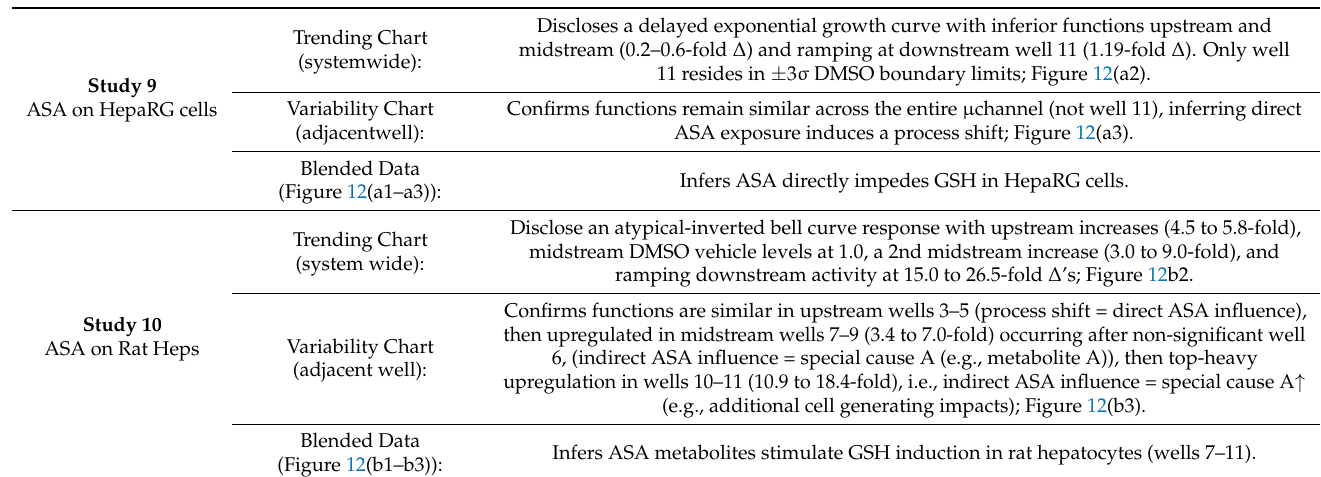
Table 8. Summary of GSH indicator